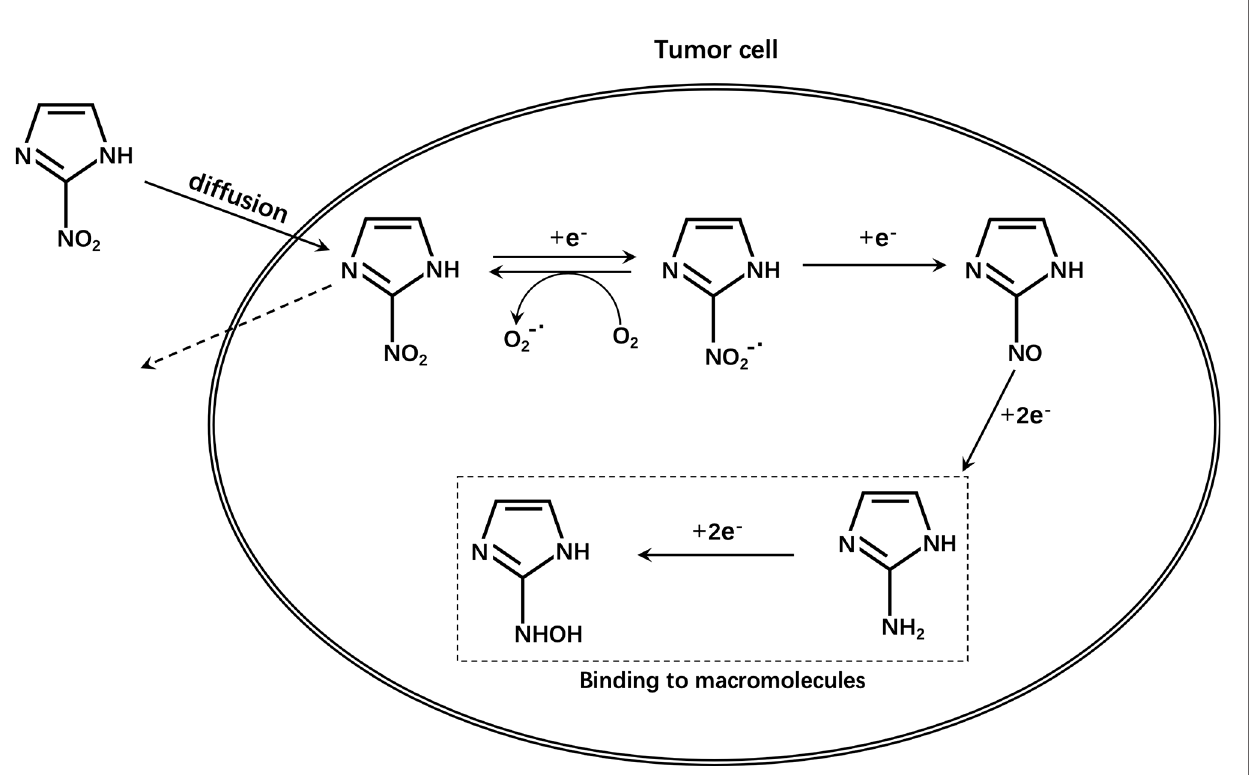
FIGURE 4 | Schematic diagram of the mechanism of nitroimidazole